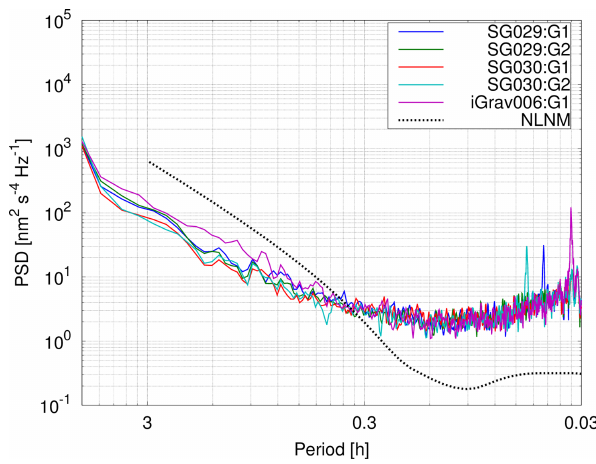
Figure 5. Noise level of the dual sphere observatory gravimeters (SG029 and 030) with sensors G1 and G2, and of gravimeter inside the field enclosure (iGrav006), expressed as the power spectral den- sity (PSD) for the time period 24 to 29 February 2016. The New Low Noise Model (NLNM) (Peterson, 1993) has been added as a reference for minimum seismic noise.